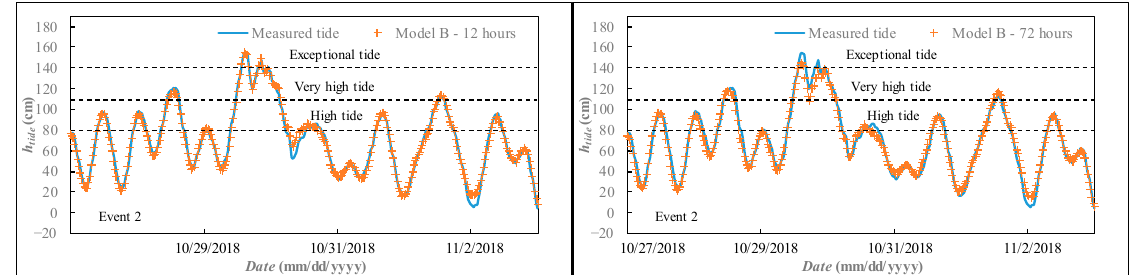
Figure 7. Event 2, extreme storm tide event forecasting for the period 27 October–3 November 2018, comparison between measured time series and predicted values: Model B, t a = 12 h (on the left ), t a = 72 h (on the right ).